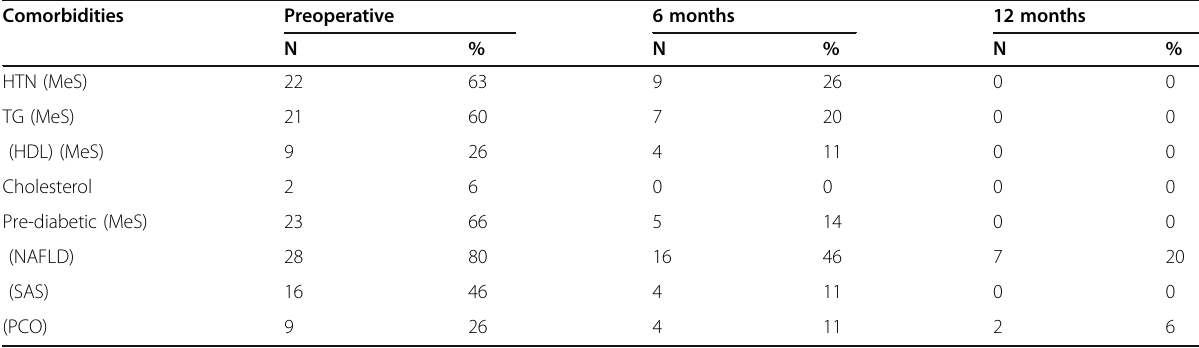
Table 2 Comorbidity resolution among patients Comorbidities